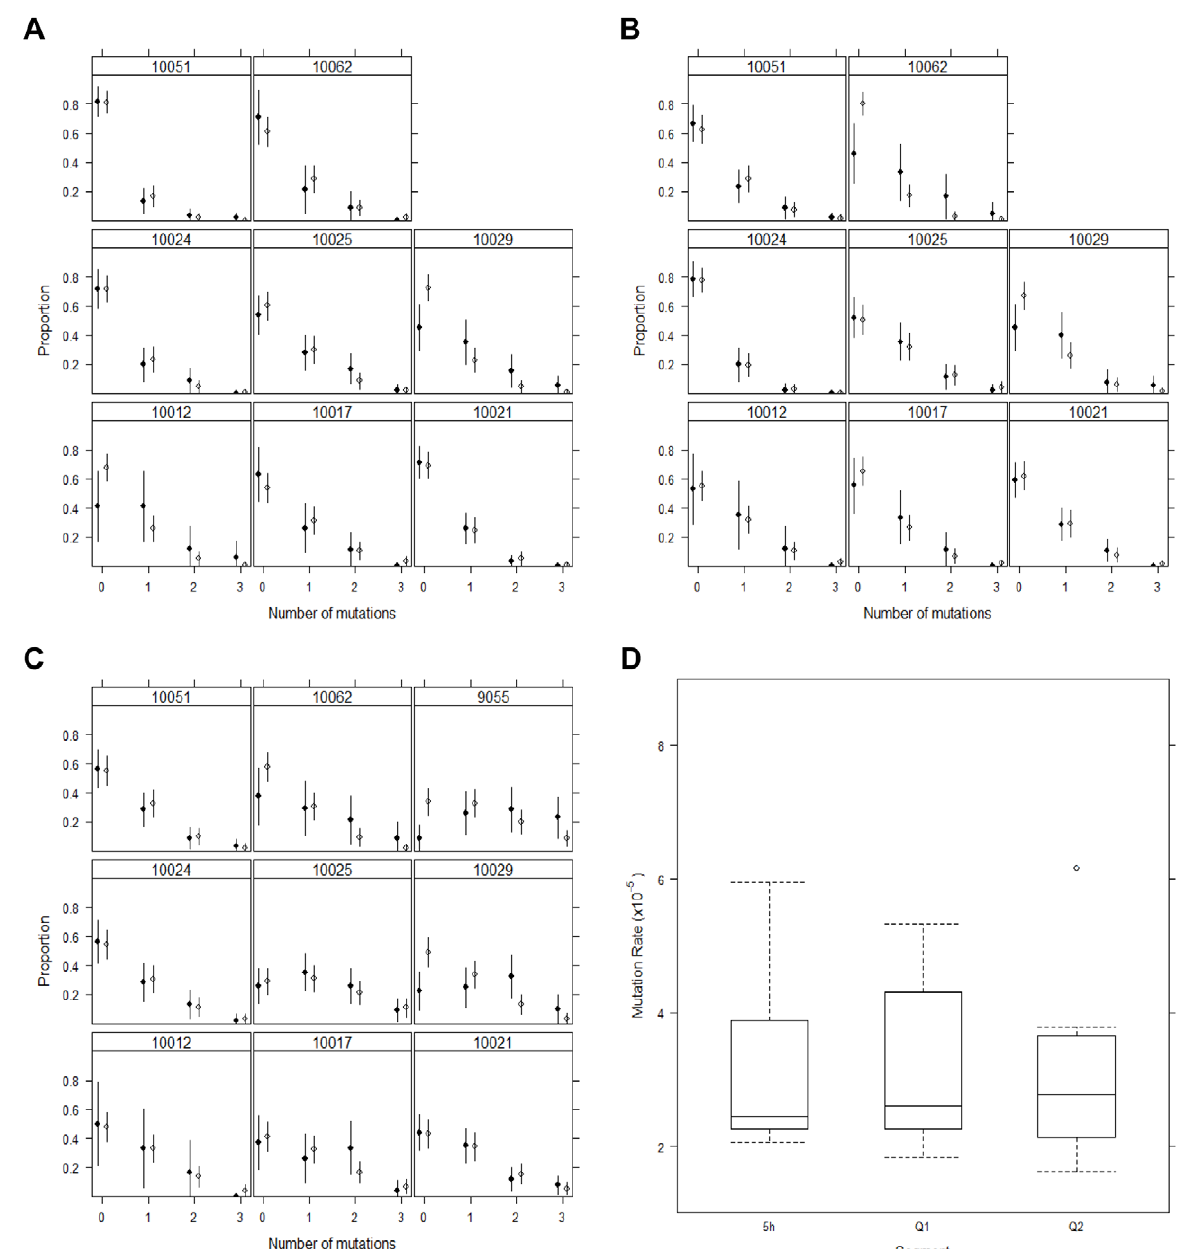
Figure 3. Spectrum of mutations in the data. The last sampling time (closed symbol) and the corresponding prediction by the model derived as the average of 100 simulations (open symbol) and respective 95% binomial CI based on the estimated mutation rates indicated in Table 1 and Figure 2 for each subject. (A) data for the first quarter (Q1) of the 5 9 HCV genome (note that for subject 9055, there is no data for Q1 or Q2); (B) data for the second quarter (Q2) of the 5 9 HCV genome; (C) data for the 5 9 half of the HCV genome. (D) Summary box plot of estimated mutation rates for the different genomic segments.